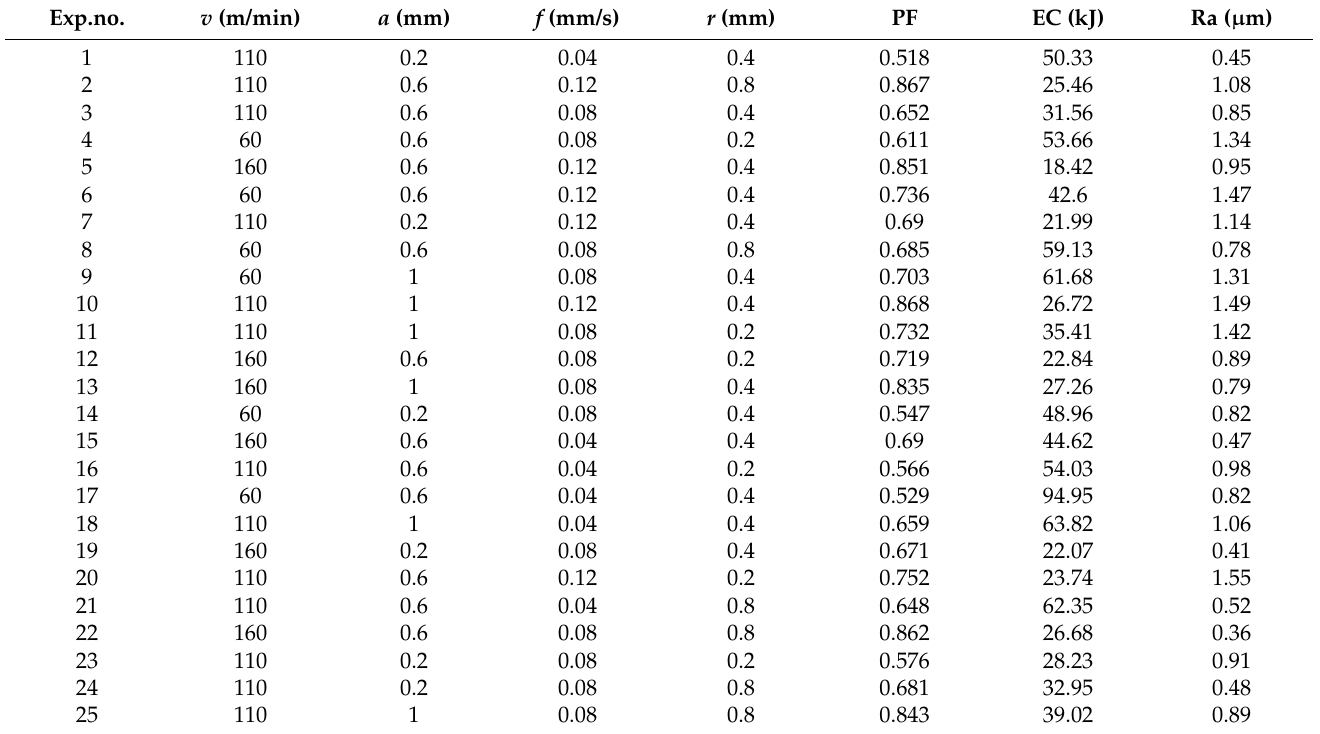
Table 2. Experimental dataset on green dry milling of SS 304 steel (case study 1)